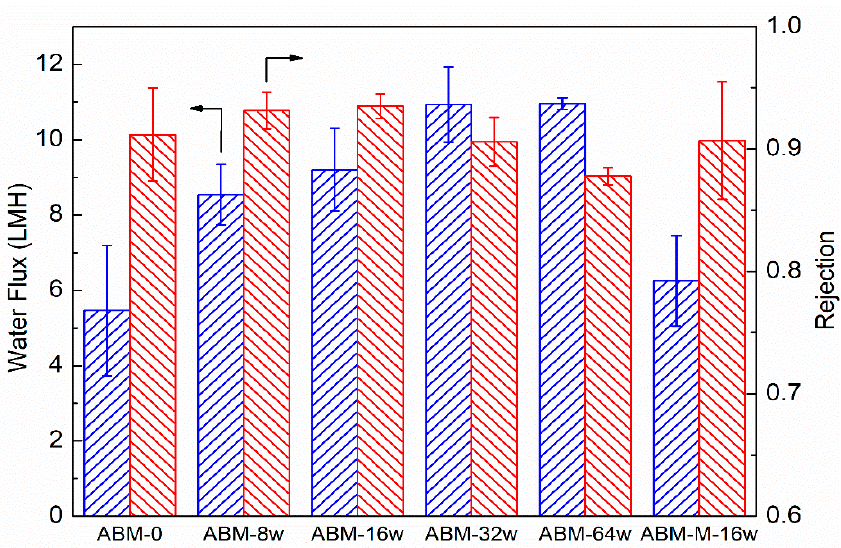
Figure 2. Impacts of the proteoliposome concentration in MPD solution on water flux and salt rejec- tion of the ABM. ABM-M-16w indicates the membrane prepared with the proteoliposome-containing mutant (concentration of proteoliposome was 0.016 wt/wt%). The PLR in all proteoliposomes was 1/200. RO tests were conducted at 5 bar, with 10 mM NaCl solution as a feed solution. The error bars were derived from results for 3 independent samples.